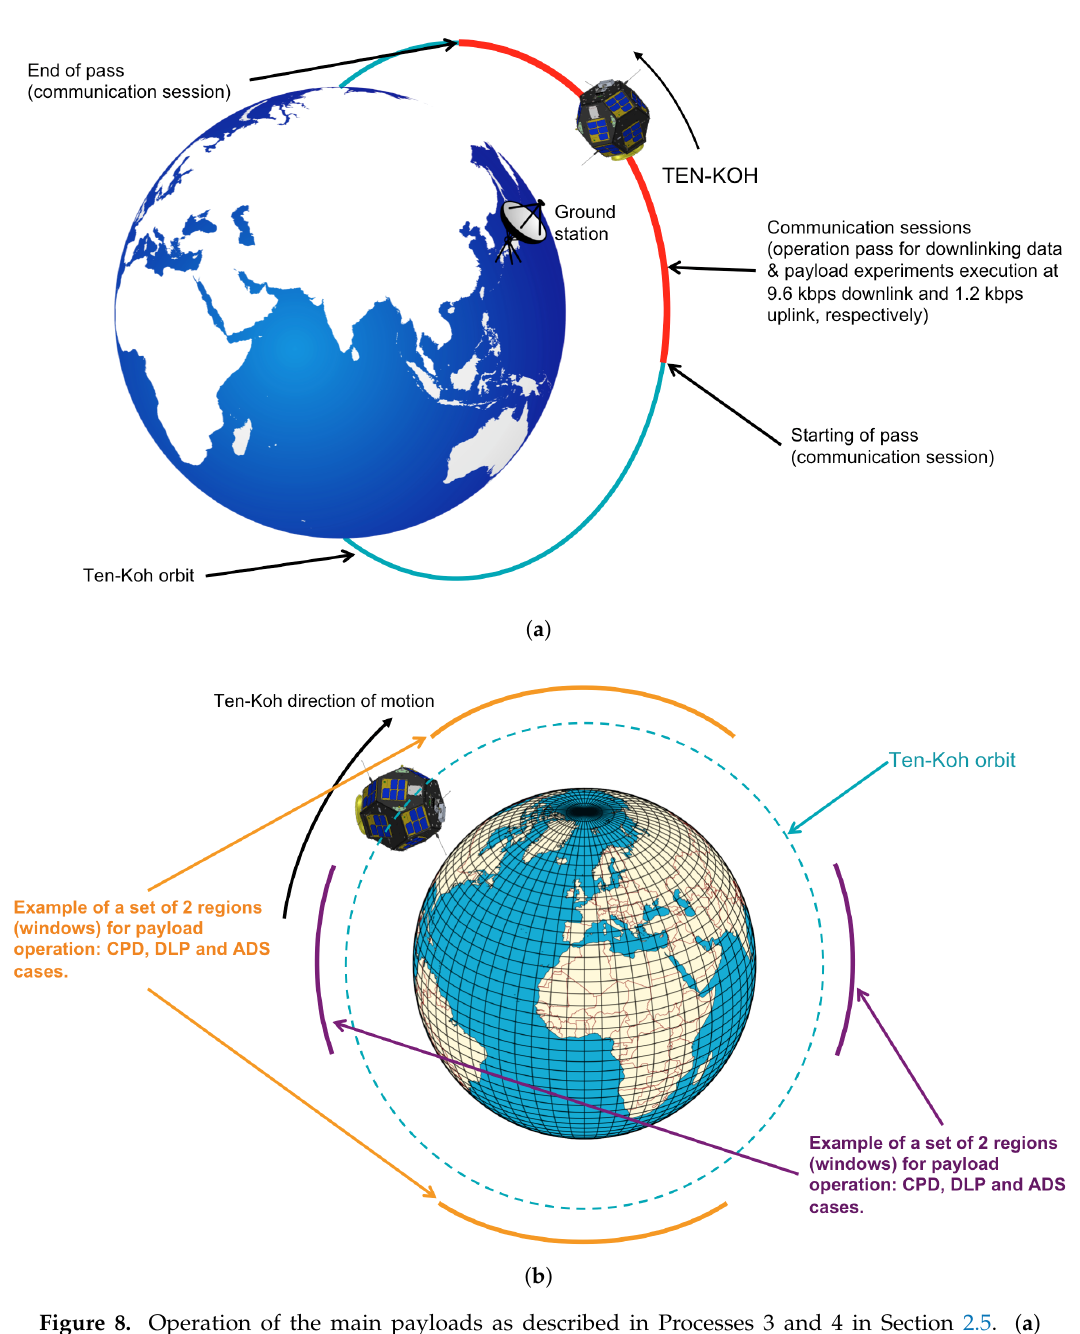
Figure 8. Operation of the main payloads as described in Processes 3 and 4 in Section 2.5. ( a ) Communication sessions between the satellite and Kyutech ground station in Japan occur in two periods, during the day at around 13:00 and during night time at around 01:00. ( b ) Mission execution for CPD, DLP and ADS in a specified region that is pre-selected and configured via a command during the communication sessions with the